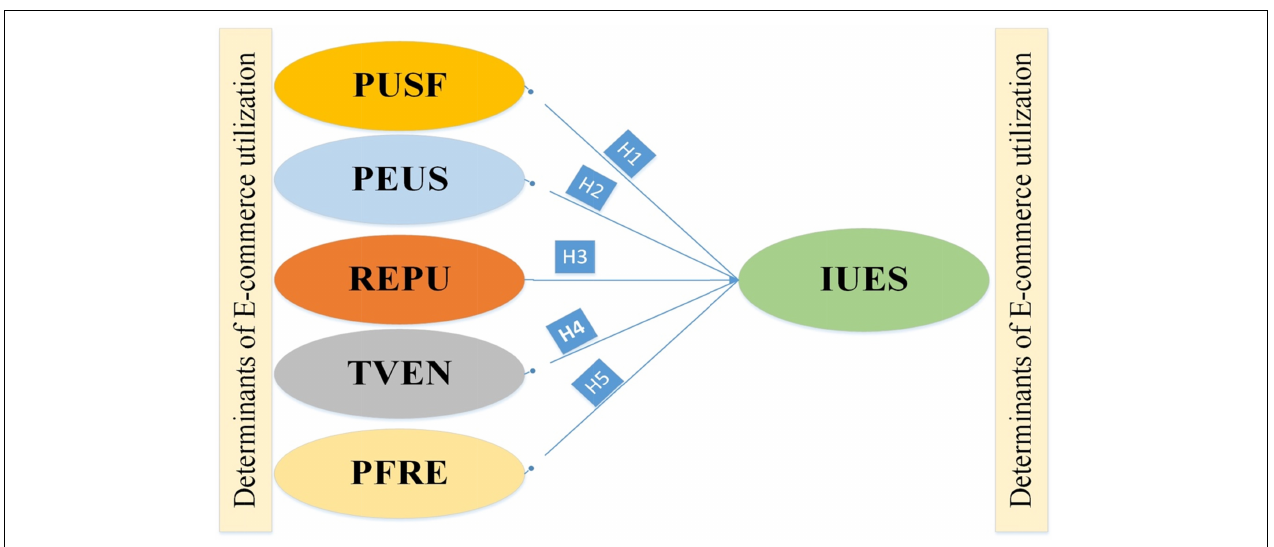
FIGURE 1 | Research